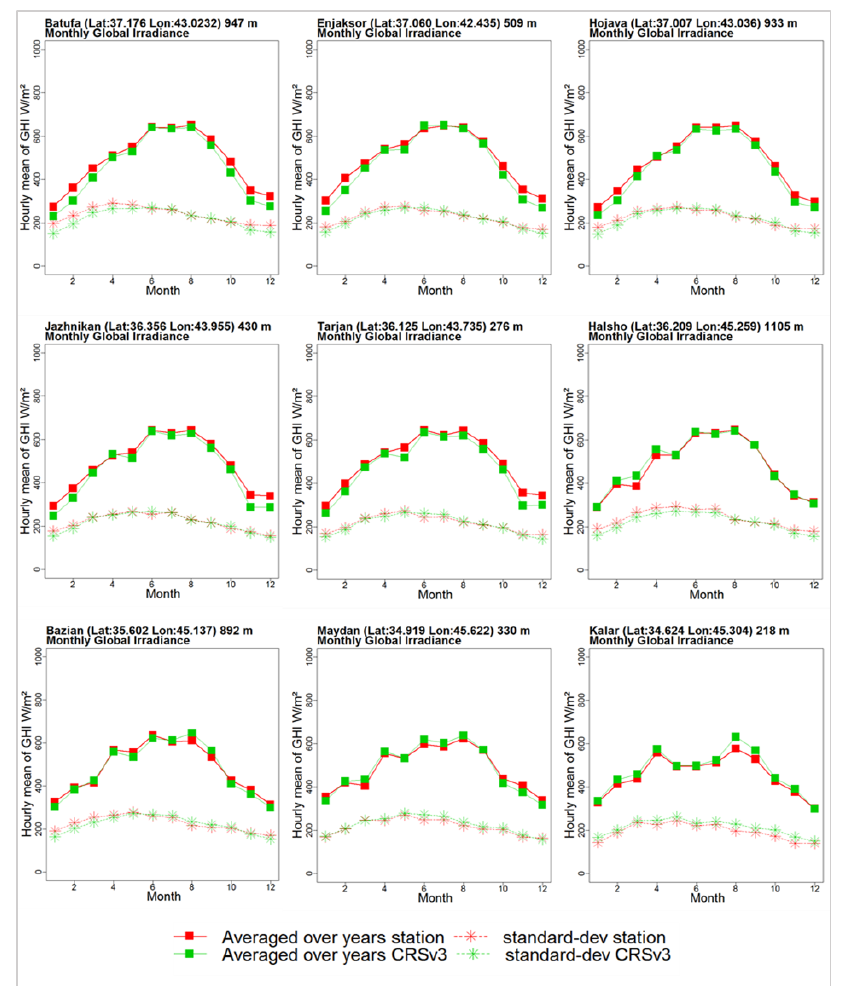
Figure 6. Monthly mean and standard deviation of hourly GHI data in each month aggregated over data availability for each station with CRSv5. The difference between dots reveals errors in a month and vice versa. If the dot of the SDD in a month is above the dot of the ground data, it denotes overestimation; otherwise, it denotes